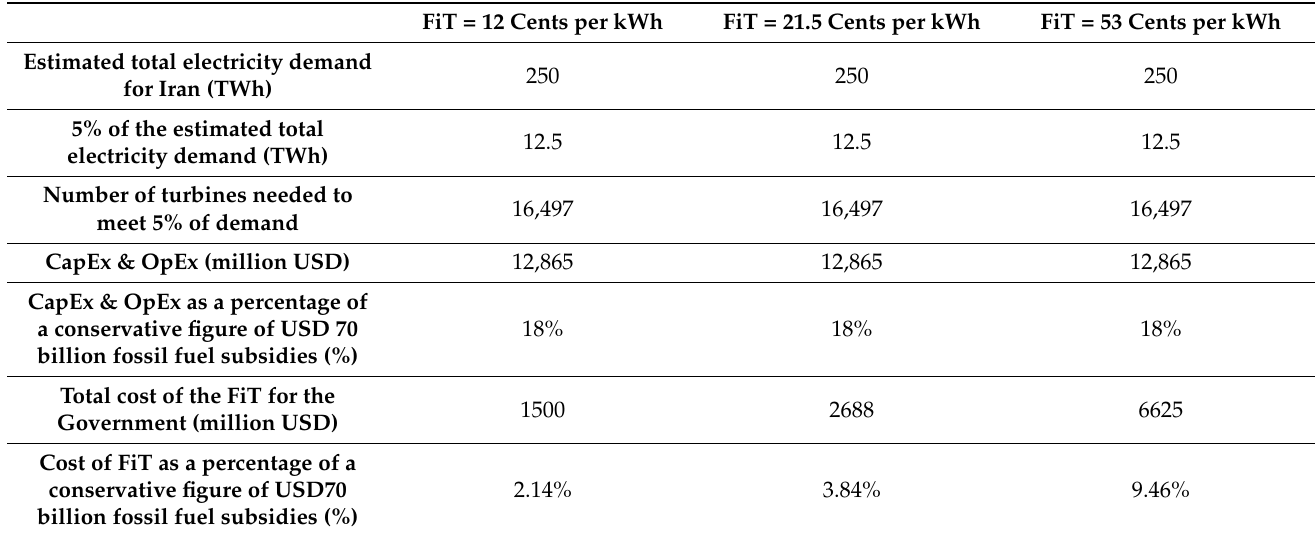
Table 6. Estimated cost of FiT and capital expenditures for the wind to meet 5% of Iran’s estimated total electricity demand. FiT = 12 Cents per